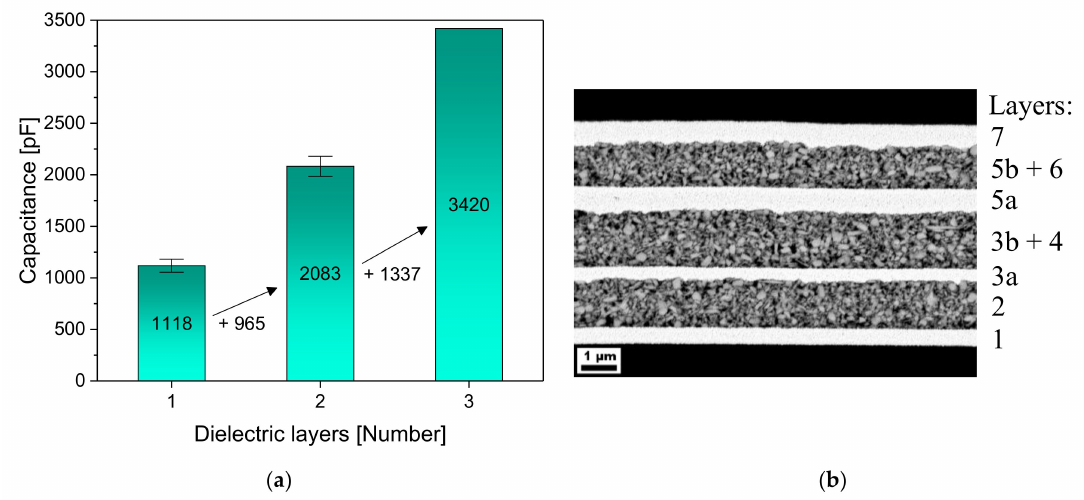
Figure 6. ( a ) Increasing capacitances of the multilayer capacitors with every additional layer, printed with drop spacings of 70-80-80 µ m; ( b ) SEM image of the corresponding three-layered capacitor, with the same labeling as in Figure 1. (1) First electrode; (2) First dielectric layer; (3a) Second electrode; (3b) Supporting structure; (4) Second dielectric layer; (5a) Third electrode; (5b) Supporting structure; (6) Third dielectric layer; (7) Fourth